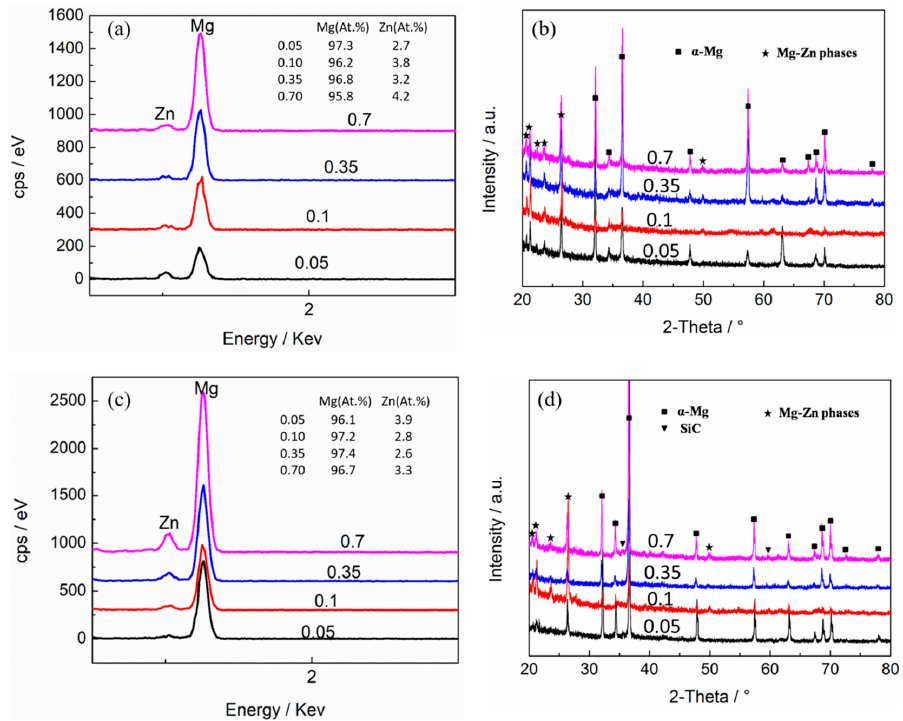
Figure 12. ( a , c ) EDS and ( b , d ) XRD of ( a , b ) the Mg-5Zn alloy and ( c , d ) the SiC p /Mg-5Zn material with different compression strains.